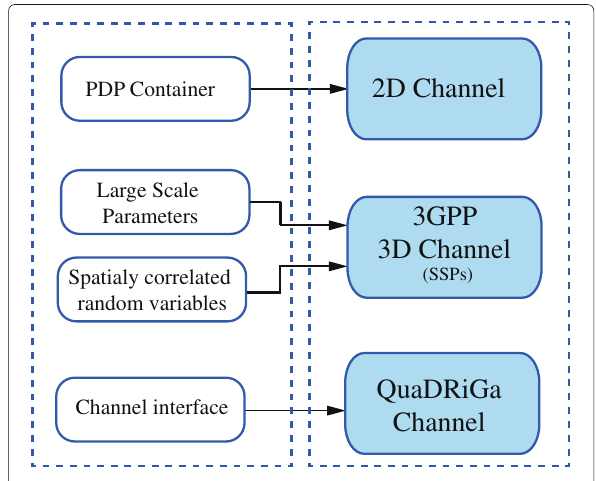
Fig. 4 Channel generation procedure. The channel generation process contains three different types of channel models: 2D channel models, 3D channel models, and a generic interface capable of incorporating outsourced channel